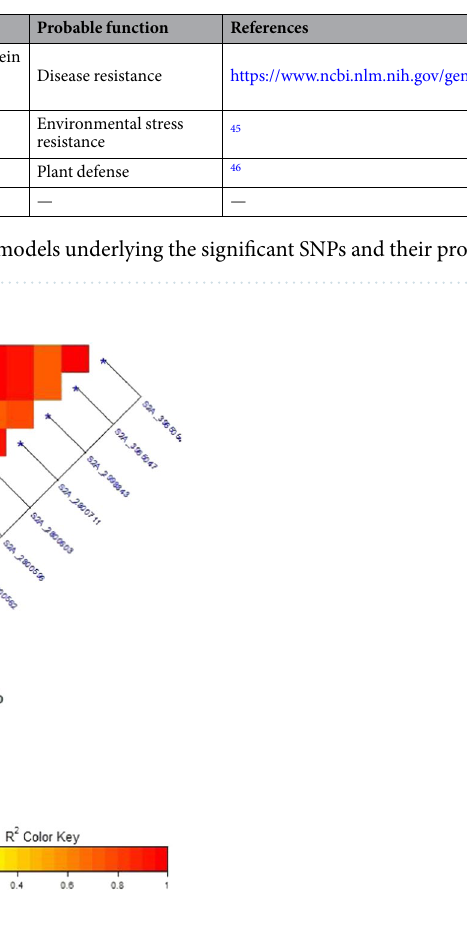
Figure 4. Linkage disequilibrium (LD) analysis in the TRP2015 population: heatmap of LD between the specific STS marker “VENTRIUP-LN2” for Sr38 resistance gene and the 17 SNPs showed highly significant LD with the marker.